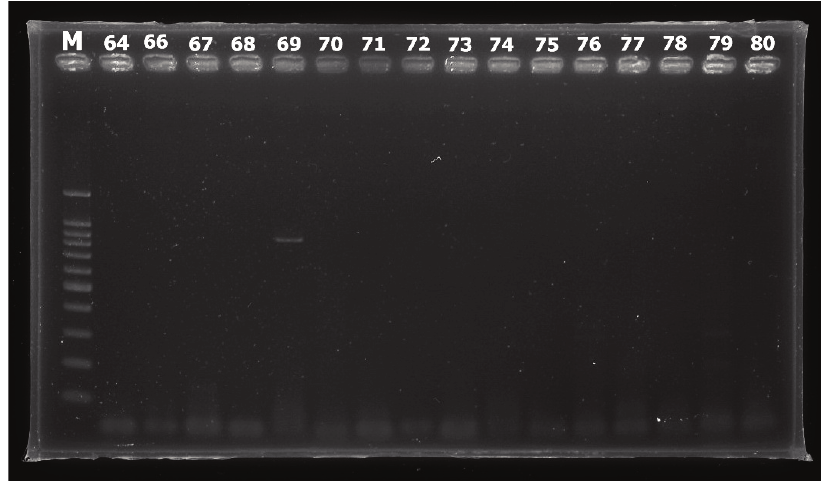
Figure 3. PCR amplification using primer